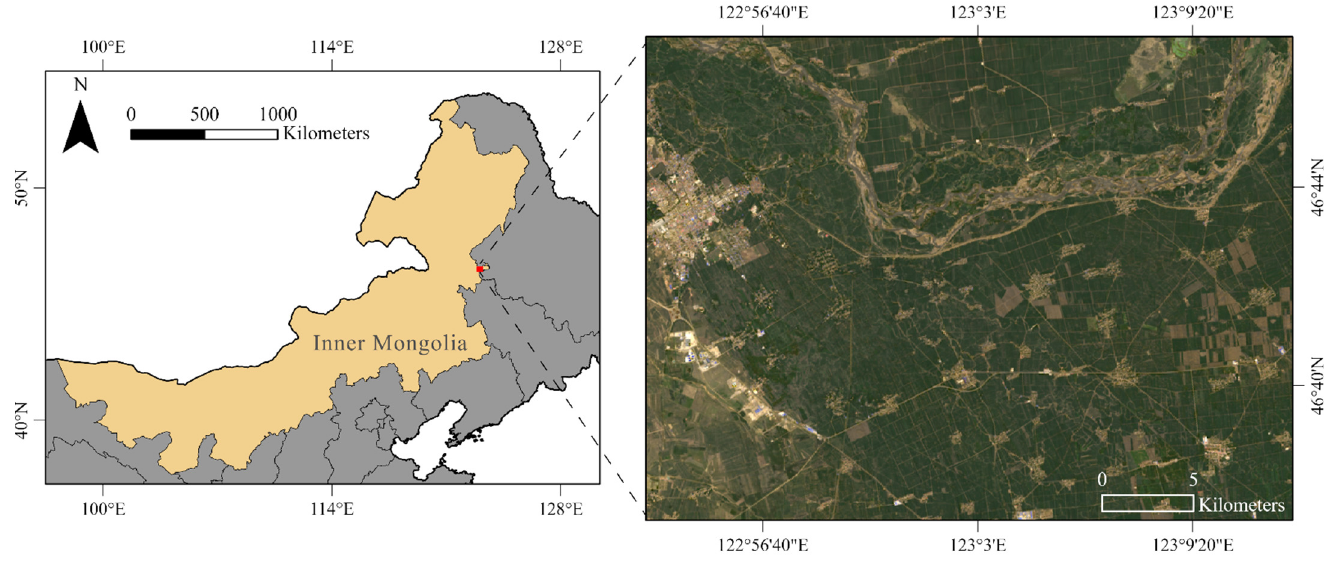
Figure 1. Location and demonstration of the study area. The image (true color composite) in the right panel was captured by Landsat 8 image acquired on 7 July 2015.